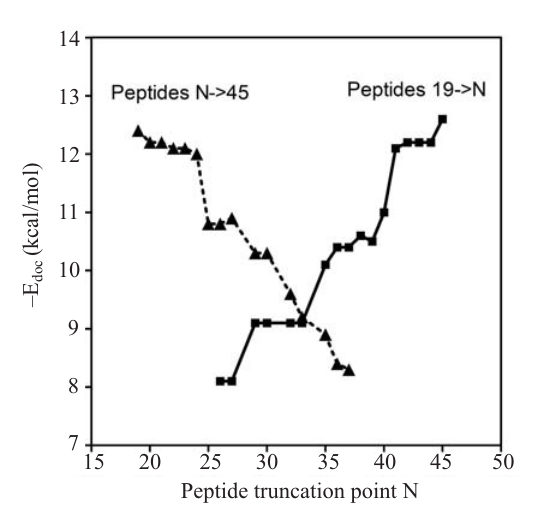
Fig. 4. Dependence of docking energy on peptide length in the case of two subseries, derived from the sequence STIEEQAKTFLDKFNHEAEDLFYQSSL (amino acids 19–45 in ACE2 structure) by systematic truncation of the N­terminus and C­terminus of the peptide. The two series are denoted as N­>45 and 19­>N, where N stands for the last number of the amino acid in the